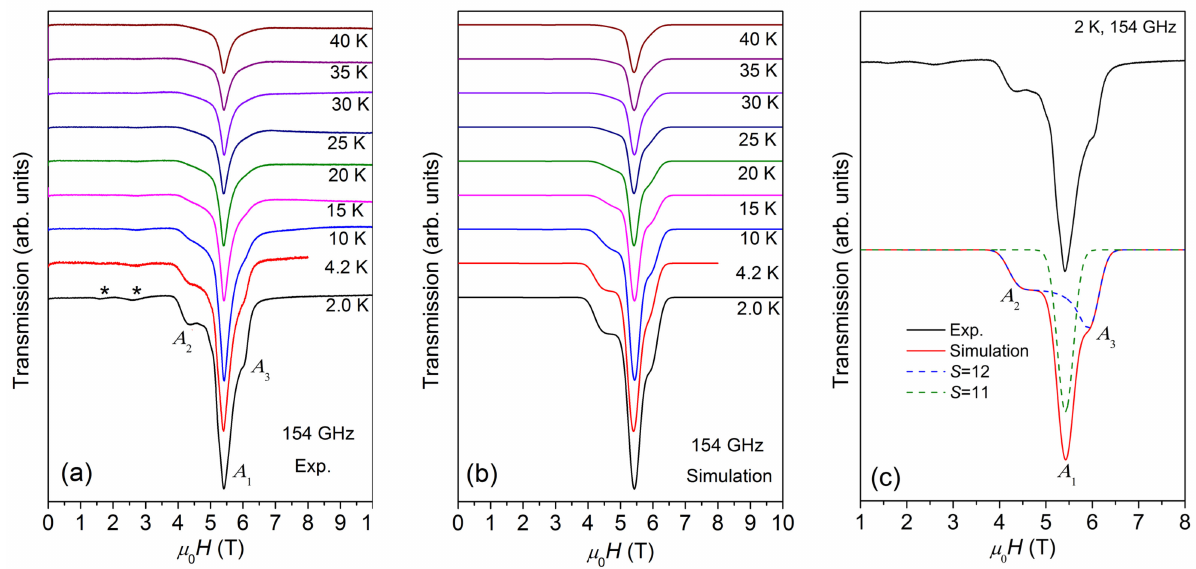
Figure 3. ( a ) ESR spectra of {Cr 8 Y 8 } measured at 154 GHz within the temperature range of 2–40 K. ( b ) Best simulations of the ESR spectra at the same conditions. ( c ) The experimental spectra (black solid line) measured at 2 K and 154 GHz, and the simulated spectra (red solid line), which includes the contributions from S = 12 (blue dashed line) and S = 11 (green dashed line). The low-temperature powder spectrum has strong high-field peaks and weak low-field peaks, indicating that D is negative (see text). The best simulation yields D = − 0.069 K for S = 12 and D ≈ 0 for S = 11